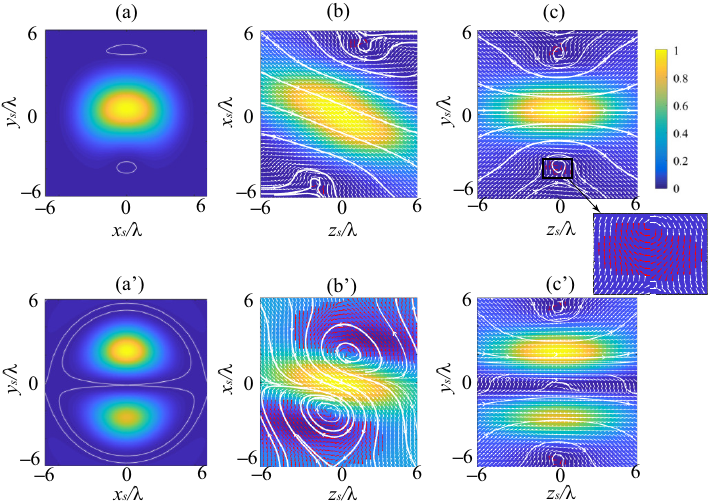
Figure 11. The longitudinal energy flow S z on the ( a , a’ ) xOy -plane, ( b , b’ ) xOz -plane and ( c , c’ ) yOz -plane. Where ( a – c ) σ c = 0.2 and ( a’ – c’ ) σ c = 15. In all plots, a = 0.5 w 0 , f = 2 mm, w 0 = 2 mm and α = 60 ◦